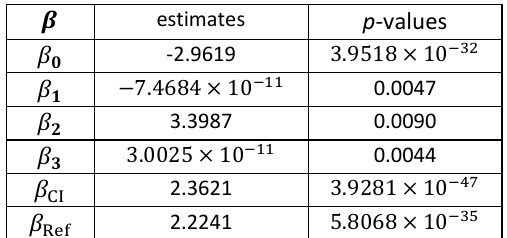
Table.4: Regression coefficient estimates and the associated p -values for the final logistic regression model